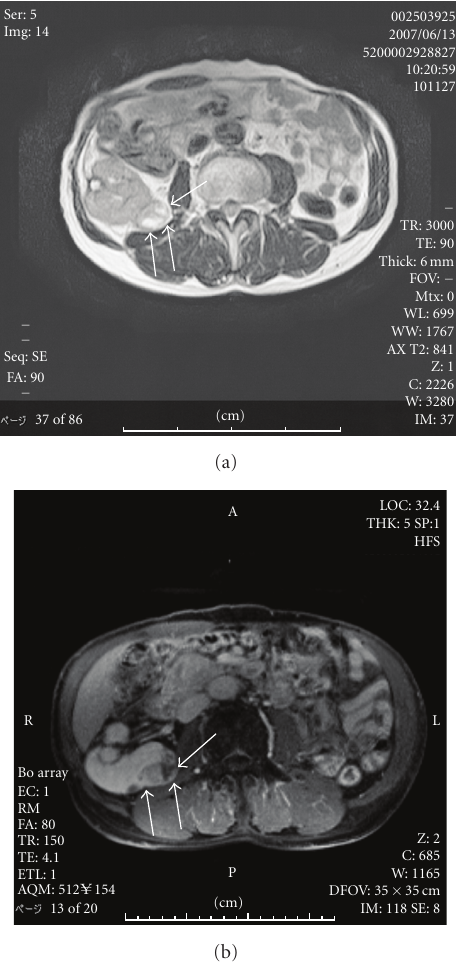
Figure 1: (a) T1-weighted magnetic resonance imaging showed a solid mass measuring 3 cm with heterogeneous intensity in the residual right kidney (case number 4). (b) The local tumor was well- controlled for 20 months after CT-guided RFA.